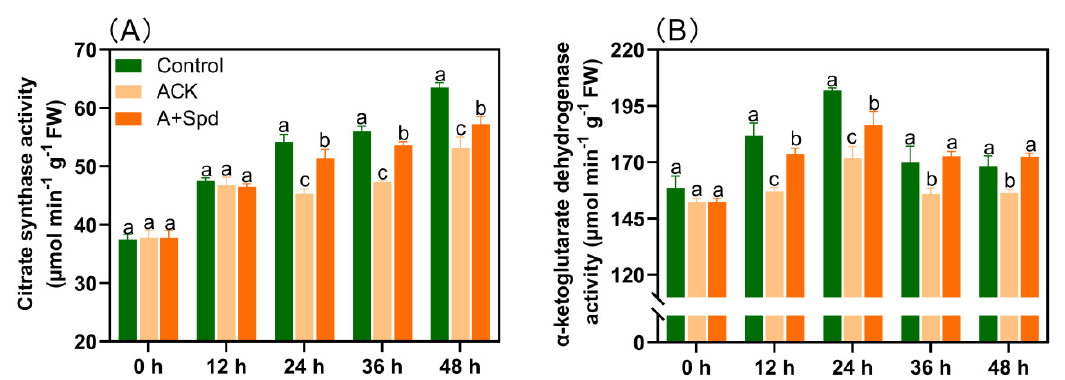
Figure 6. Exogenous Spd increases the activities of key enzymes in the TCA during germination of aged seeds. ( A ) The quantitative analysis of citrate synthase activity. ( B ) Quantitative analysis of α -ketoglutarate dehydrogenase activity. Control − healthy seeds; ACK − artificially aged seeds; A+Spd − aged seeds with Spd treatment. A total of five time points from 0 to 48 h after germination were performed for each treatment. Different lowercase letters above the bars indicate significant levels of difference among the three treatments ( p < 0.05, Lsd). A 0.05 µ M concentration of exogenous Spd was used.